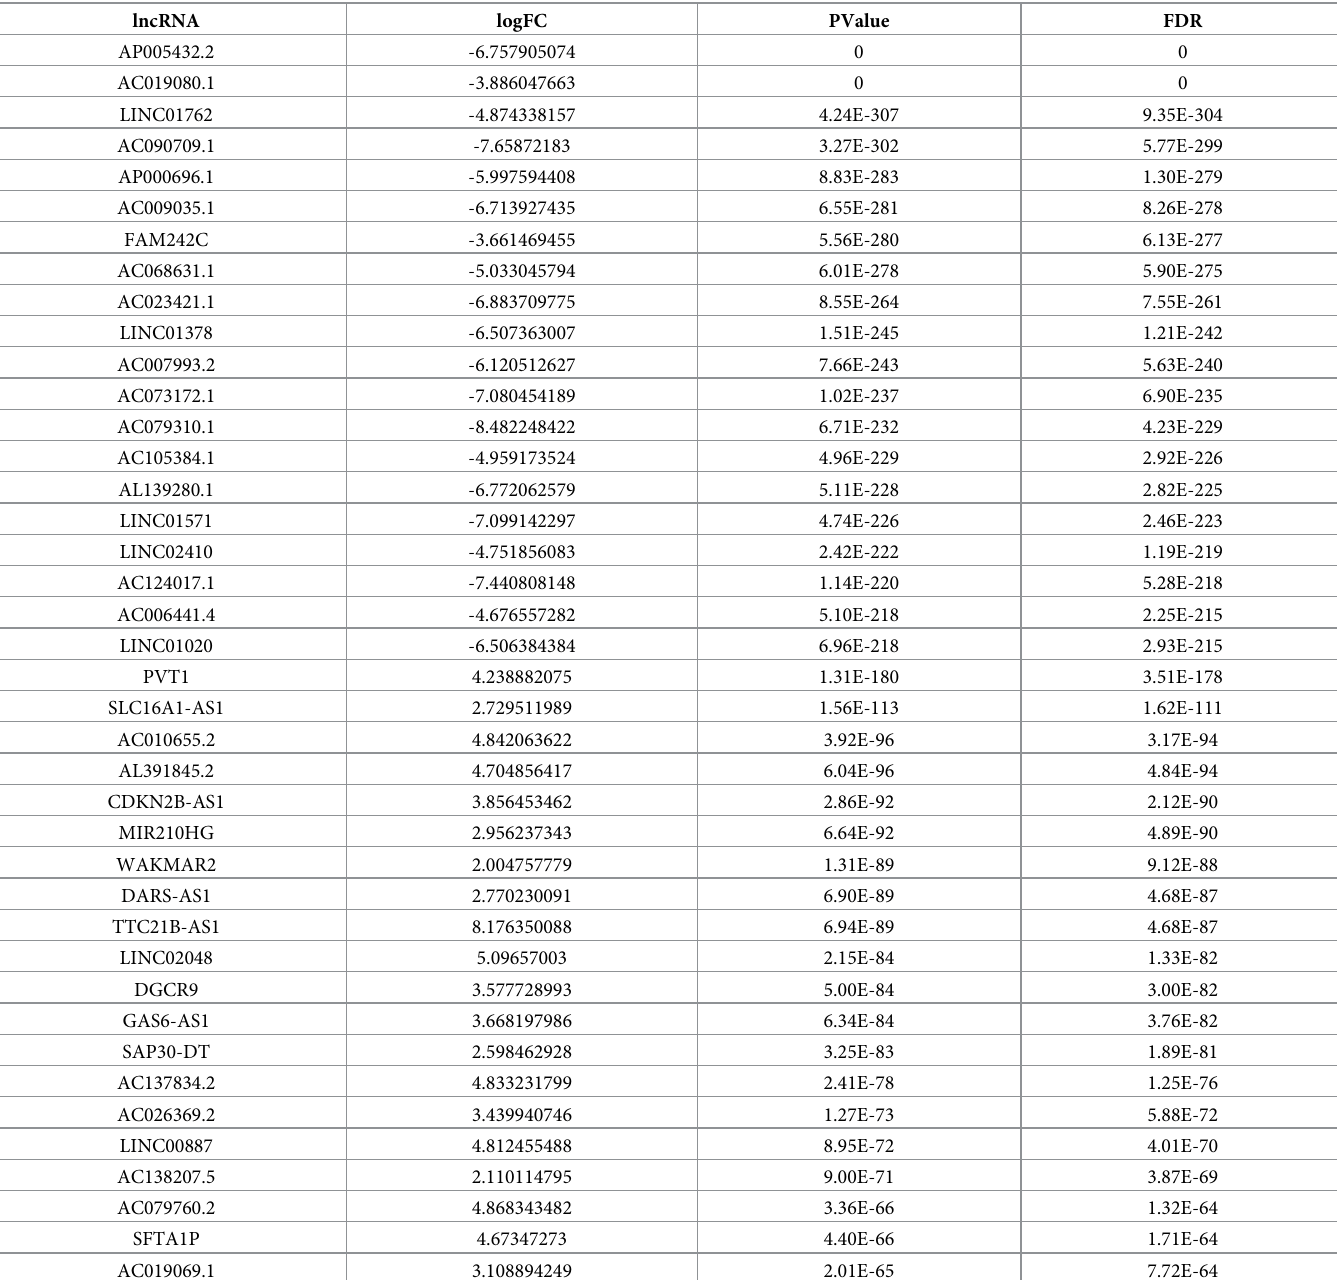
Table 2. Top 20 upregulated and downregulated lncRNA in patients with